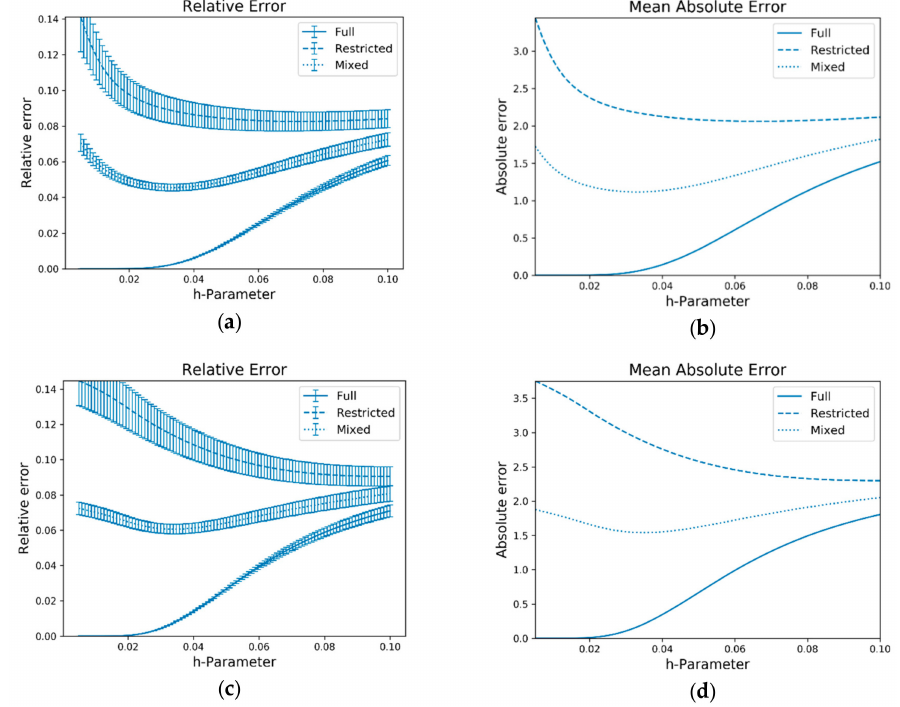
Figure 14. Results of the Cooling load problem for the complete and reduced variable dataset models with the parameter selection h = ω . ( a ) MAPE depending on h for the model with 8 variables; ( b ) MAE depending on h for the model with 8 variables; ( c ) MAPE depending on h for the model with 5 variables; ( d ) MAE depending on h for the model with 5